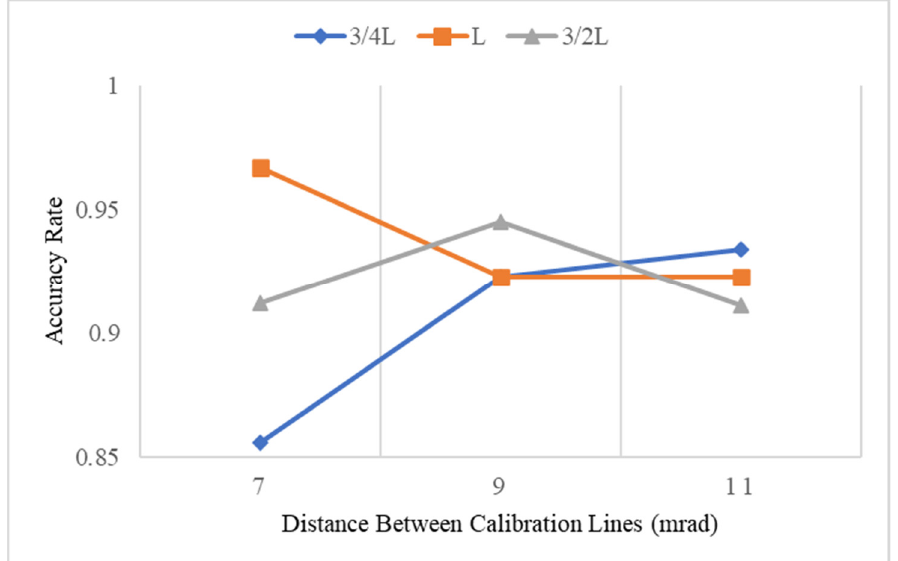
Figure 6. Task accuracy rate by distance between calibration lines and layouts of horizonal calibration scale belts.